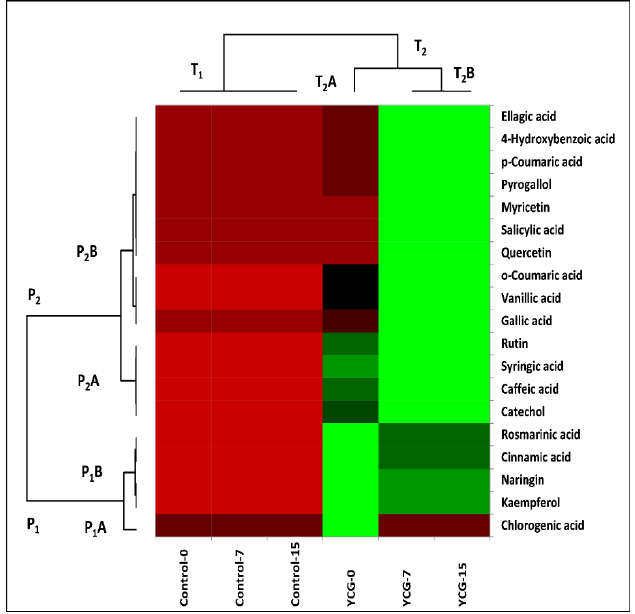
Figure 1. Heat map estimated from quantitative data of phenolic compounds concentration in different treatments. The scale of color moves from red to green with increased concentration.